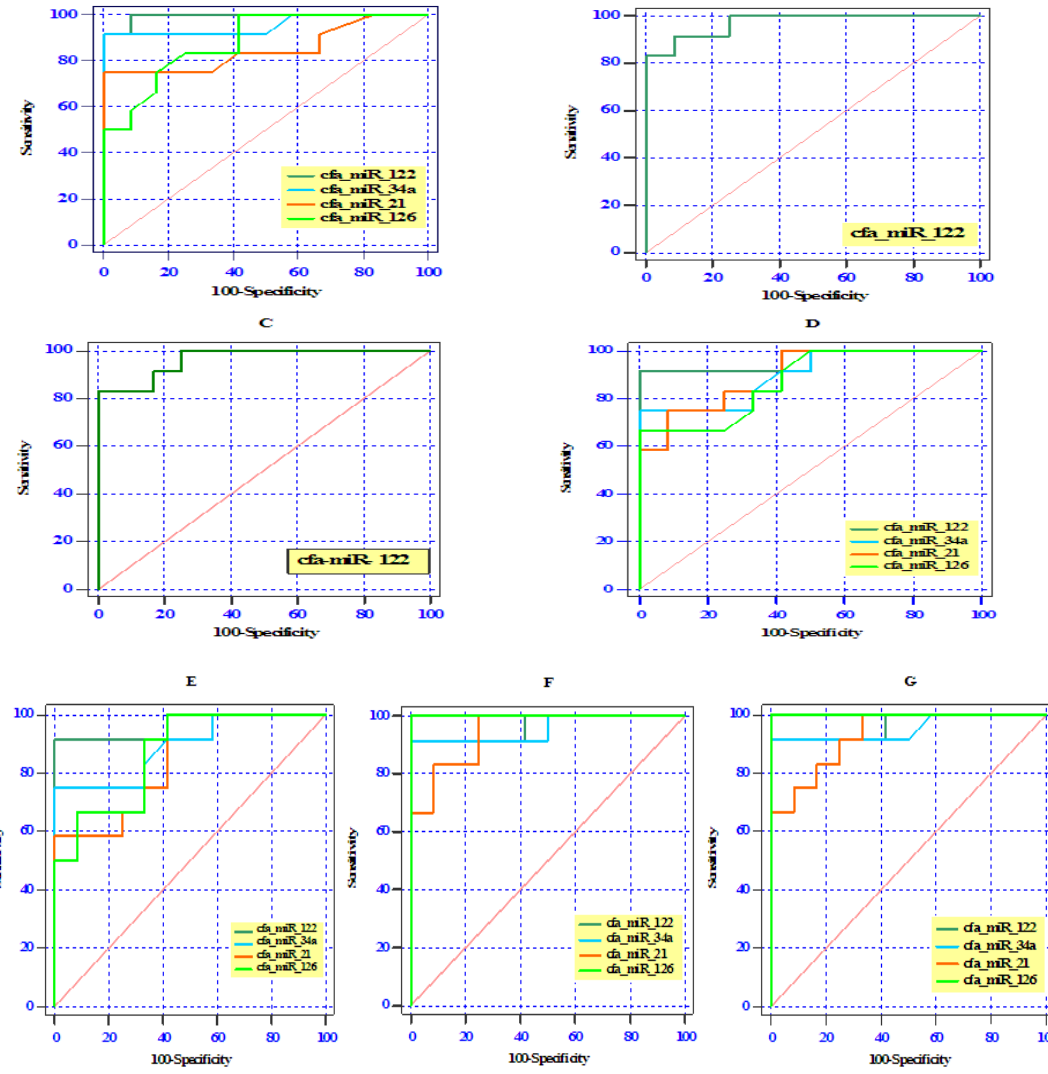
Figure 4. Receiver operating (ROC) curve analysis of the differentially expressed cfa-miRNAs among the studied groups (splenocaval (A) , splenophrenic (B) , splenoazygos (C) , RGC (D) , RGC–CL (E) , right divisional (F), and left divisional (G) ) and the control group.